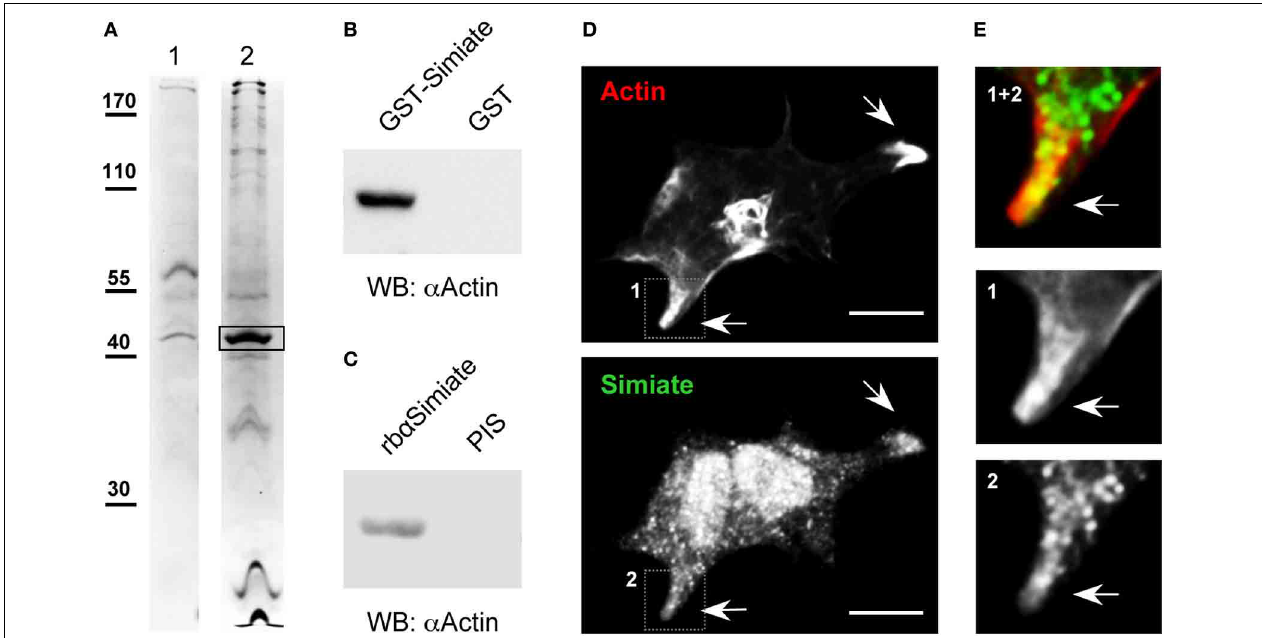
FIGURE 1 | Actin and Simiate associate. (A) Representative acrylamide gel lanes from a coprecipitation assay with covalently coupled GST-Simiate and mouse brain cytosol. 1: GST control. 2: GST-Simiate. The box indicates a protein band subjected to MALDI-TOF analysis and identified as β -Actin in two independent experiments. (B) A coprecipitation assay with purified GST-Simiate and pure G-Actin, illustrated by western blotting with Actin-specific antibodies.